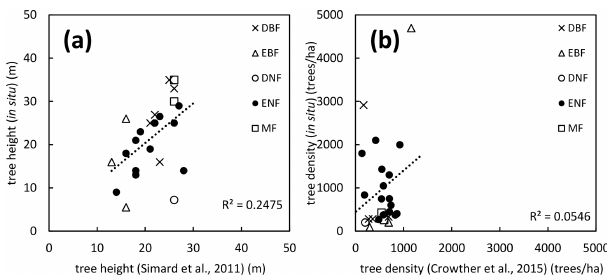
Figure 2. (a) Relationship between available in situ estimates of tree height (in meters) with Simard et al.’s (2011) estimate. (b) Re- lationship between available in situ estimates of tree density (trees per hectare) with Crowther et al.’s (2015) estimates. DBF – decidu- ous broadleaf forest; EBF – evergreen broadleaf forest; DNF – de- ciduous needleleaf forest; ENF – evergreen needleleaf forest; MF – mixed